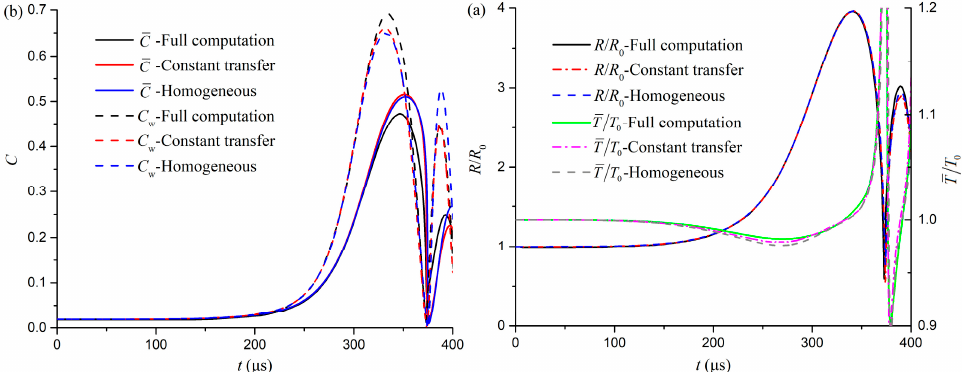
Figure 6. ( a ) Bubble radius, average temperature, and ( b ) concentrations of case I predicted by the full computation [19], constant-transfer model, and homogeneous model. The prediction by the homogeneous model matches well with that by the constant-transfer model before bubble rebound.